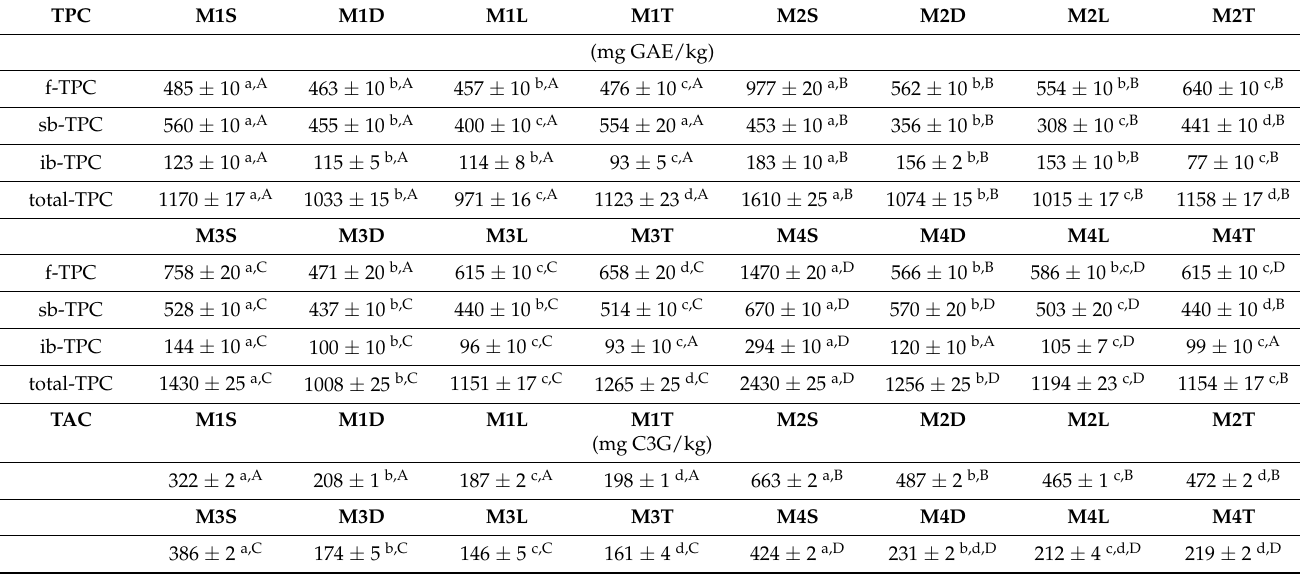
Table 2. Total phenolic and anthocyanin contents of nutraceutical mixtures under the defined storage